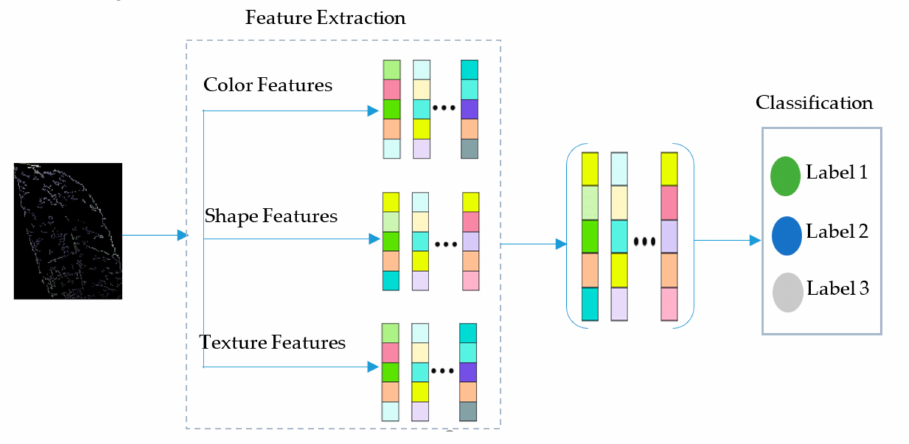
Figure 4. Structure of feature